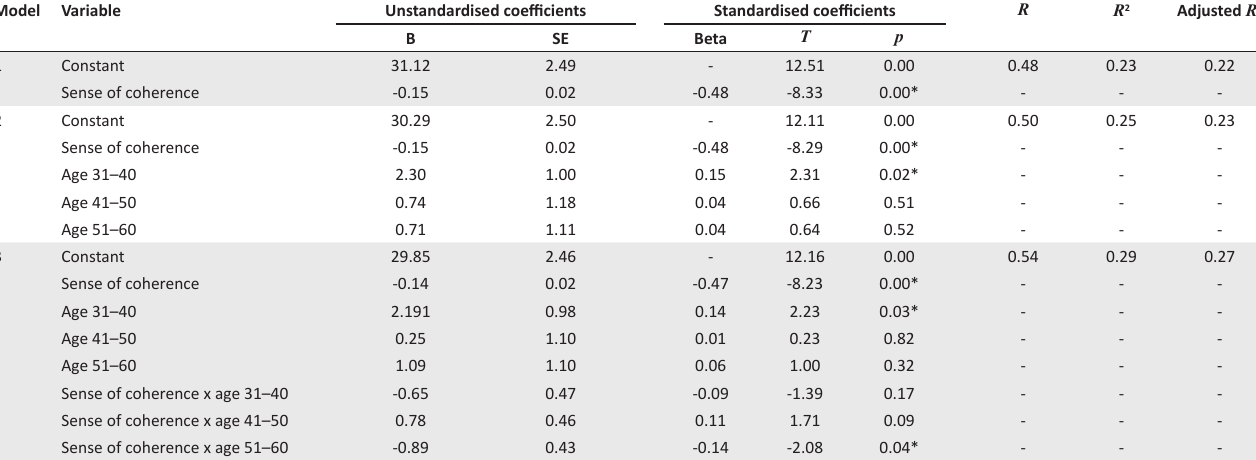
TABLE 4: Moderated multiple regression with exhaustion as the dependent variable. Model